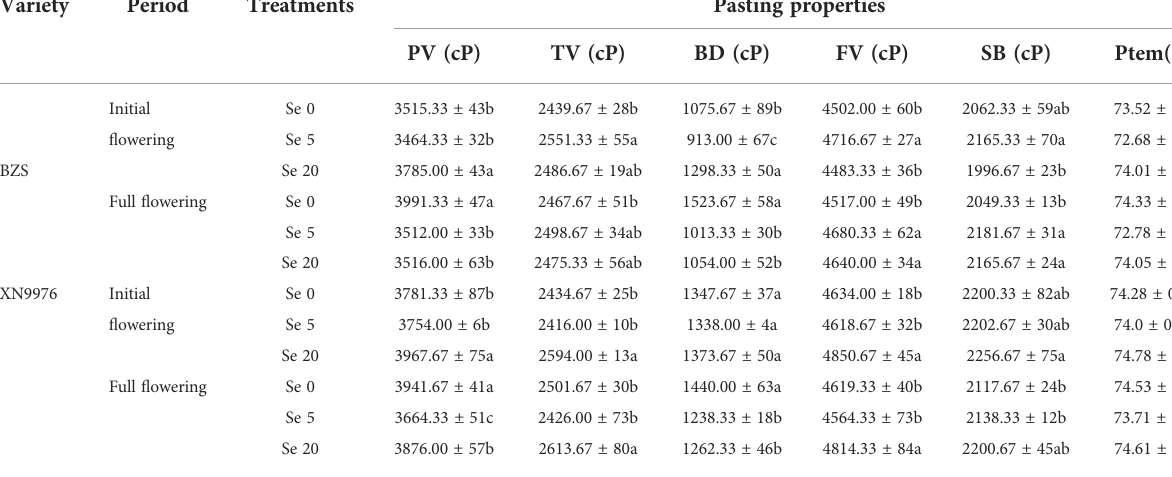
TABLE 3 Pasting properties of common buckwheat starch under different selenium treatment levels. Variety Period